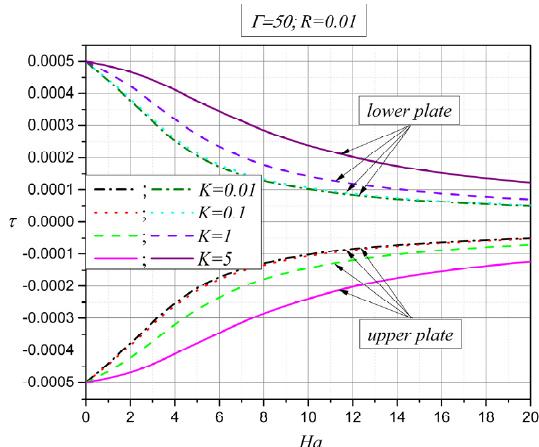
Figure 12. Shear stress at upper and lower plates as a function of Hartmann number and coupling parameter 𝐾 .